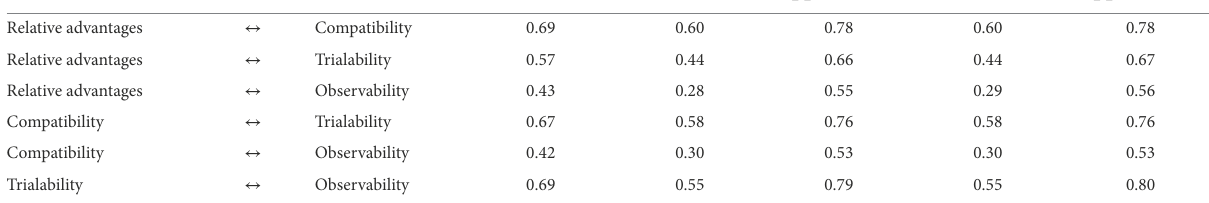
TABLE 7 Diffusion of innovations theory - bootstrap correlation coefficient 95% confidence interval.